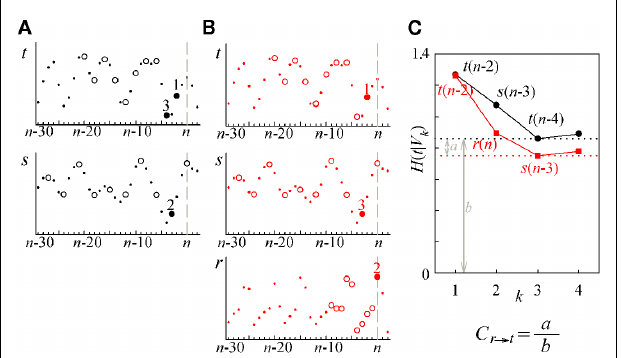
FIGURE 3 | Illustrative example of estimation of causal coupling from respiratory flow to heart period time series. (A,B) Representative short sequences of the three series t , s , and r (dots), plotted together with the sets of initial candidate terms (circles, separated to each other by the lag τ peculiar of each series) for the first repetition (A) and the second repetition (B) of the conditioning scheme followed to estimate the causal coupling from r to t ; filled circles denote the selected terms, with the number indicating the step k at which selection occurred; the vertical dashed lines mark the current time sample n . (C) Conditional Entropy computed for the first (black) and second (red) repetitions of the conditioning procedure; the candidate components selected at each step of the procedure are indicated in the plot; horizontal dashed lines mark the resulting entropies H ( t |{ ˜ Ys , Yt } ) and H ( t |{ ˜ Ys , ˜ Yr , Yt } ) , which, combined as in Eq. 2a, yield the causal coupling C r → t